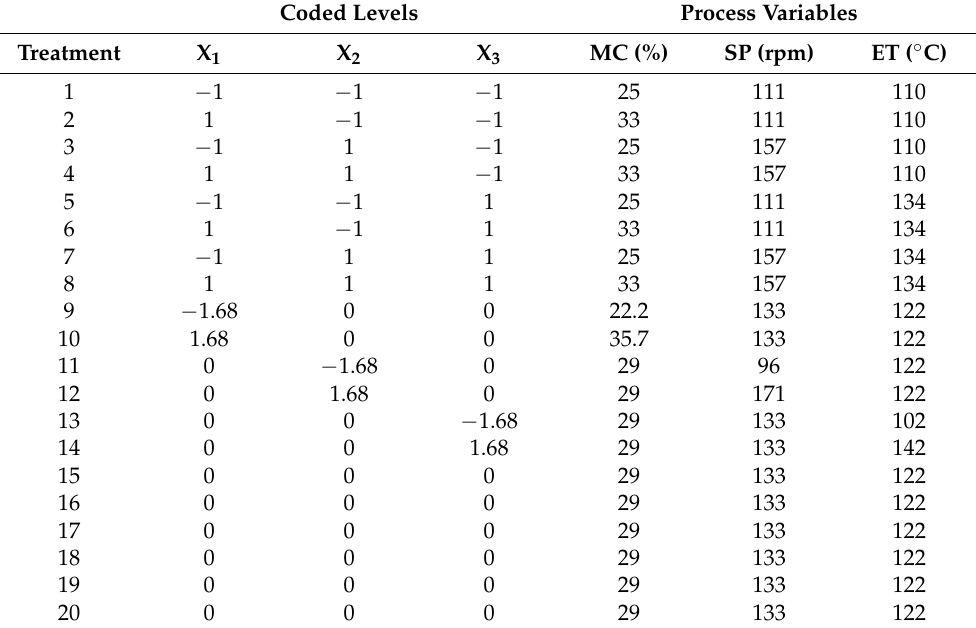
Table 1. Process variables and levels used in the experimental design.